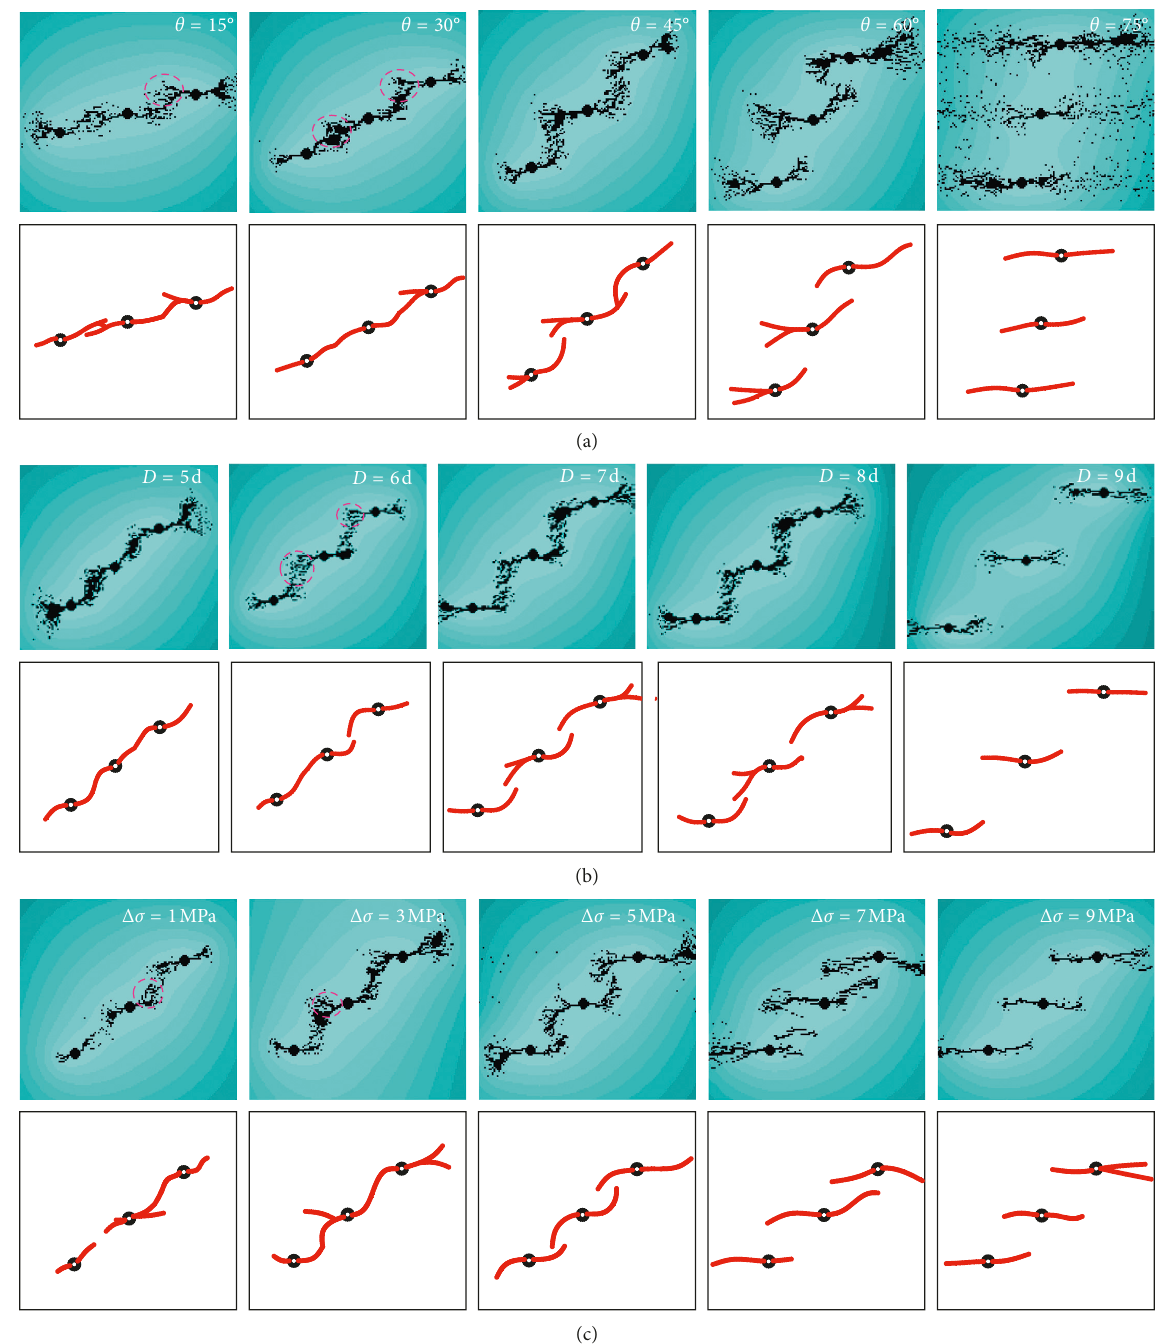
Figure 8: Crack propagation of directional hydraulic fracturing controlled by dense linear multihole drilling with various parameter values. (a) Angle θ between borehole direction and σ 1 . (b) Borehole spacing D . (c) Difference in principal stress Δ σ